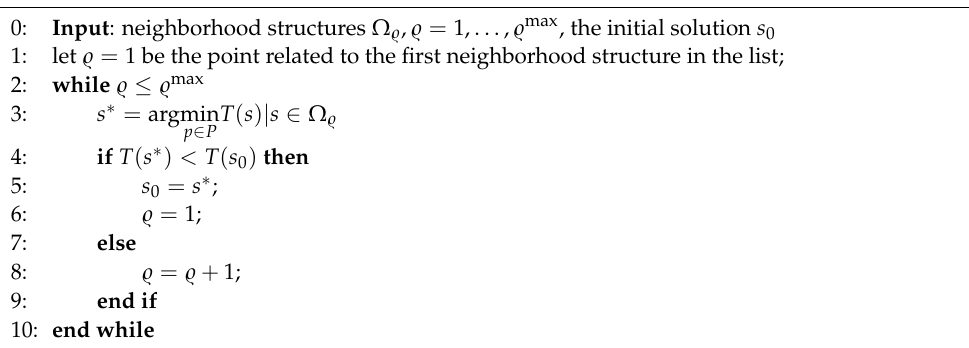
Algorithm 2 Variable Neighborhood Descent